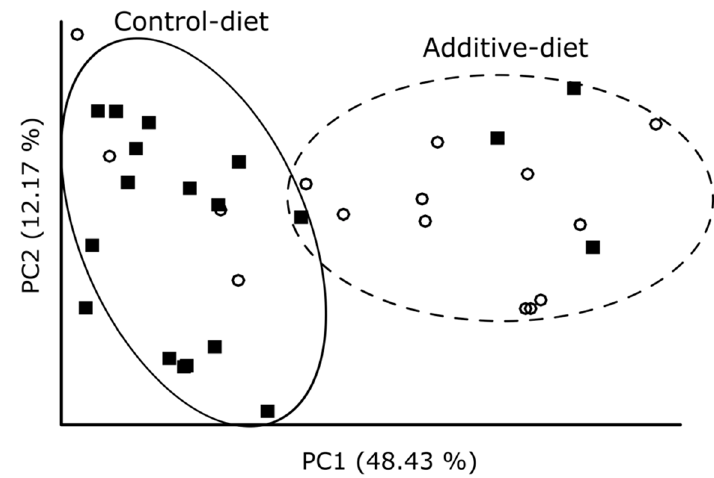
Figure 3. Principal Coordinates Analysis (PCoA) of the 16S rRNA gene amplicon Amplicon Single Variants (ASVs) based on Weighted UniFrac distances. White circles represent additive-diet lamb fecal samples whereas black squares represent additive-diet ones.